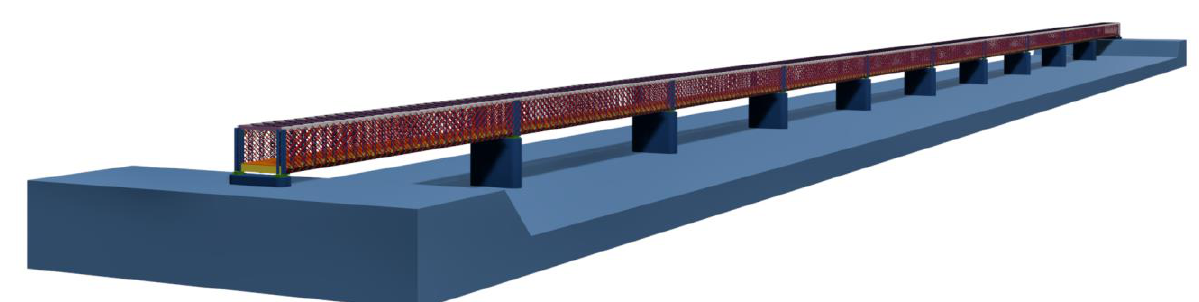
Figure 10 . A general view of the bridge in Mezzana